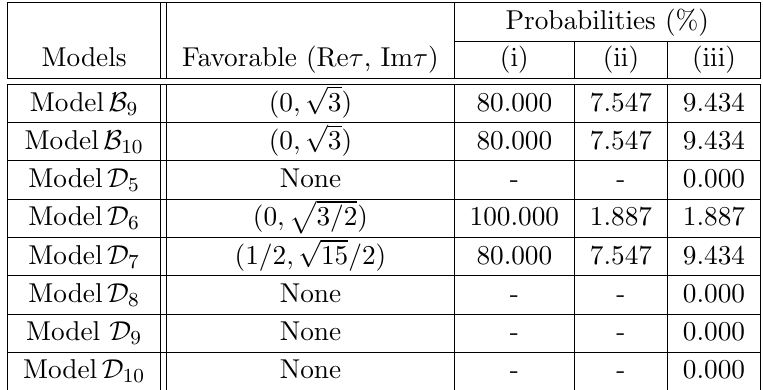
Table 16 . The theoretically favored vacuum expectation values of (Re (cid:28); Im (cid:28) ) within each region for the N max = 10 case. We also show the probabilities of (i) the favorable value in each model, (cid:13)ux (ii) the favorable value in whole fundamental domain of SL(2 ; Z ) moduli space and (iii) the allowed moduli region in the string